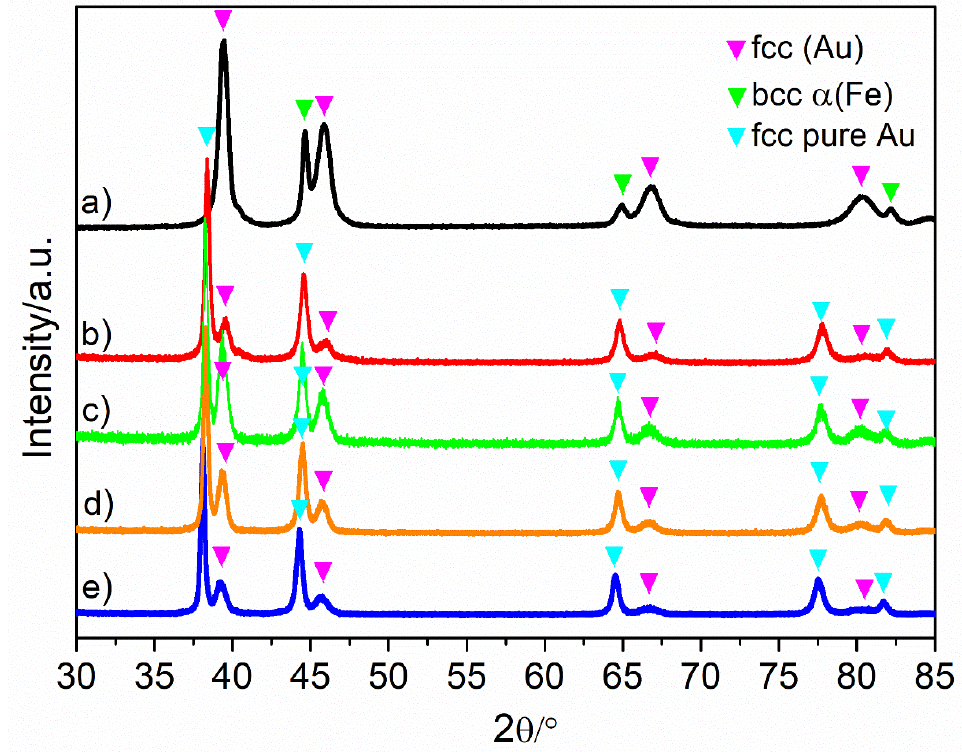
Figure 2. XRD patterns of ( a ) the as-quenched ribbon, ( b ) NPG_8h, ( c ) NPG_12h, ( d ) NPG_14h, and ( e ) NPG_16h.